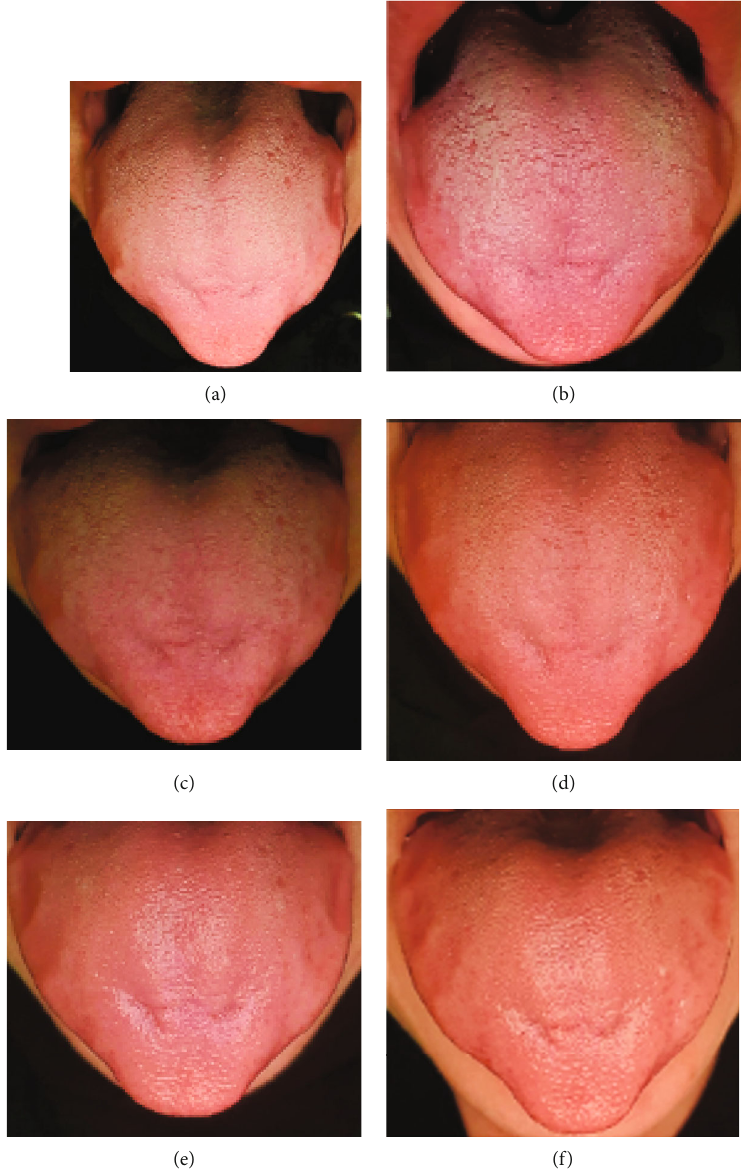
Figure 1: (a – f) Tongue feature changes along four weeks of follow-up. Week one (a, b): (a) visit 1 showing white coated tongue with prominent papillae; (b) visit 2 showing increased tongue coat thickness over the dorsal lateral aspects with prominent papillae. Week two (c, d): (c) visit 3 showing case stability from visit 2; (d) visit 4 showing improvement with restoration of the normal tongue coating and papillary features. Weeks three and four (e, f) showing further improvement than the previous weeks with normal tongue coating and